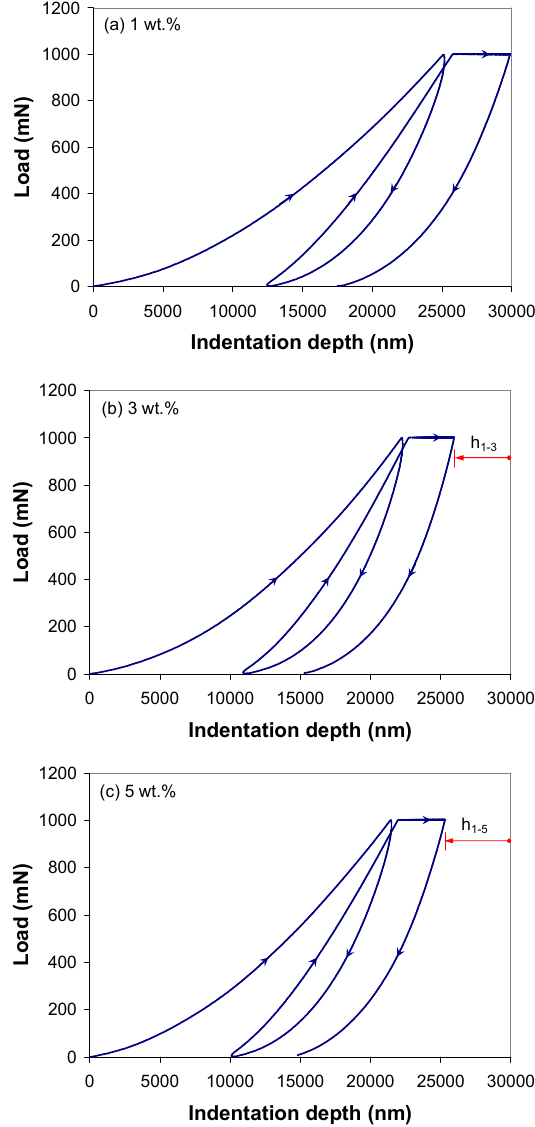
Figure 5. Experimental load-depth curves for 2-cycle indentation on the PP/MWCNT nanocomposites at 2000 mN/min loading/unloading rate and 300 s holding time.